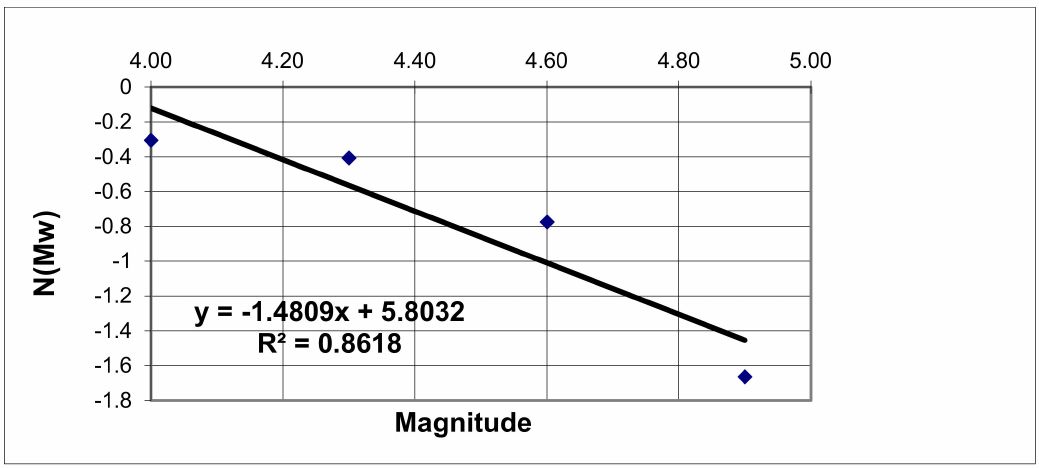
Figure 10. Gutenberg–Richter recurrence relationship curve for source zone